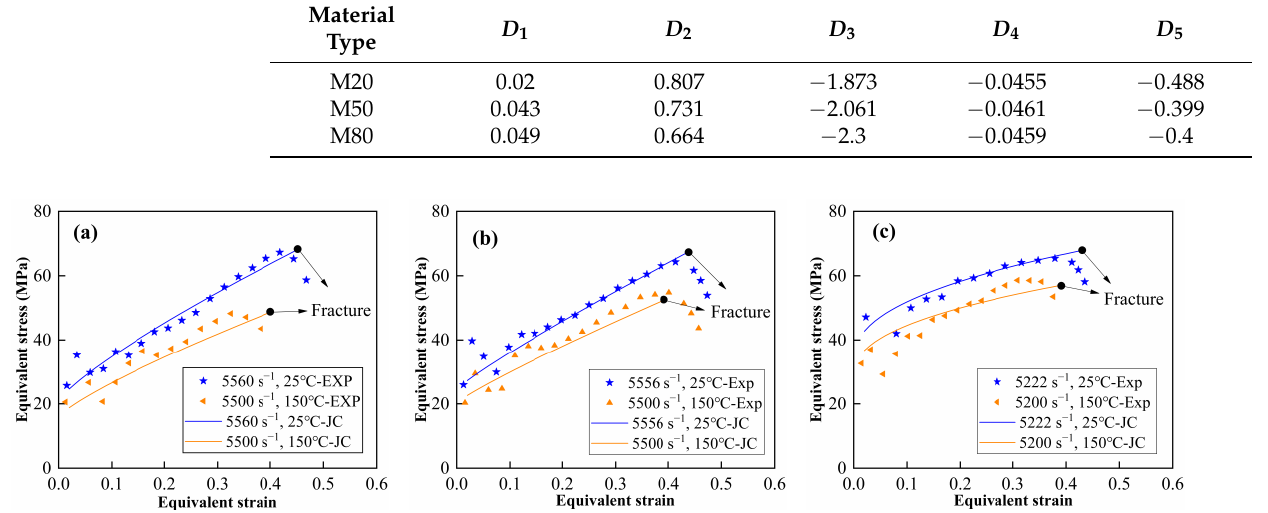
Figure 15. Comparison between the tested and JC model predicted stress–strain curves: ( a ) M20, ( b ) M50 and ( c ) M80.